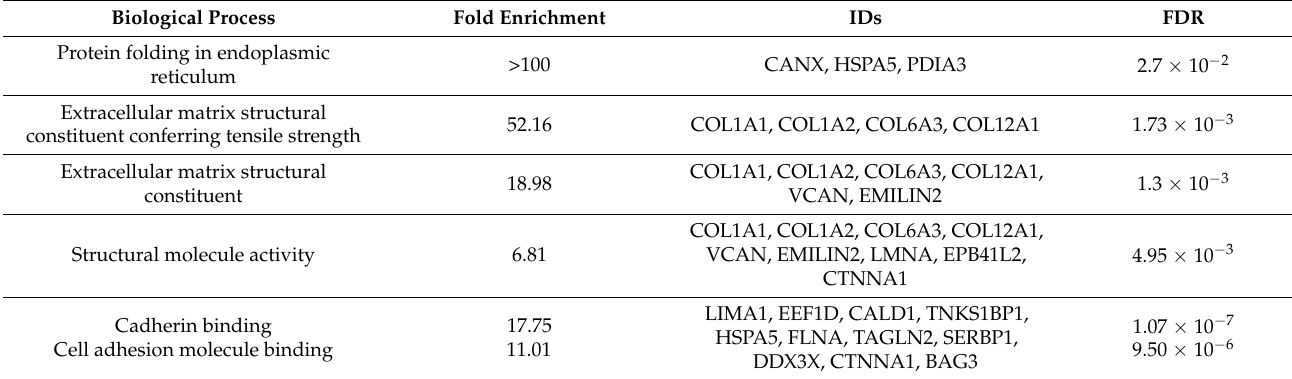
Table 1. Biological processes and molecular function terms enriched in GO analysis using 38 proteins IDs retrieved from LC/MS-MS